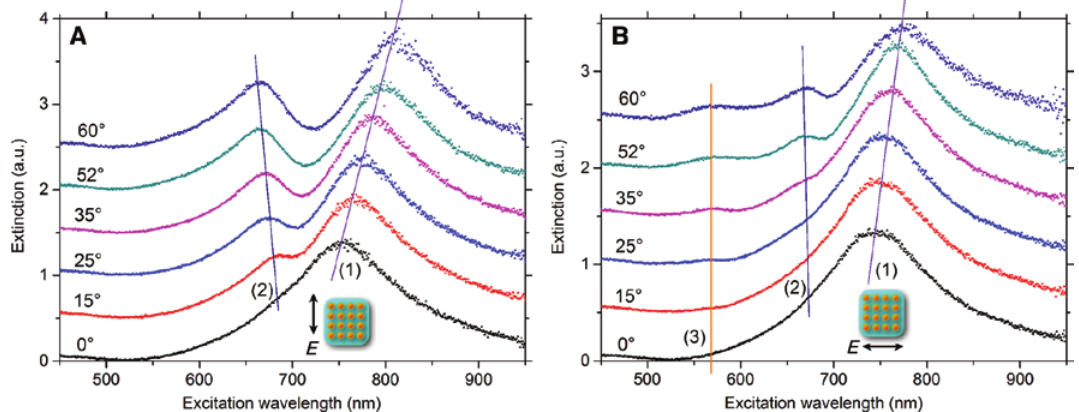
Figure 4: Extinction measurements resolved in angle in TE polarization (A). At normal incidence, only the dipolar mode [ λ ~ 740 nm, (1)] is excited while, by increasing the incidence angle, the quadrupolar mode [ λ (B), only the dipolar mode (1) is also excited. When the incidence angle increases beyond 35 ° , the quadrupolar mode (2) and the vertical mode (3) are